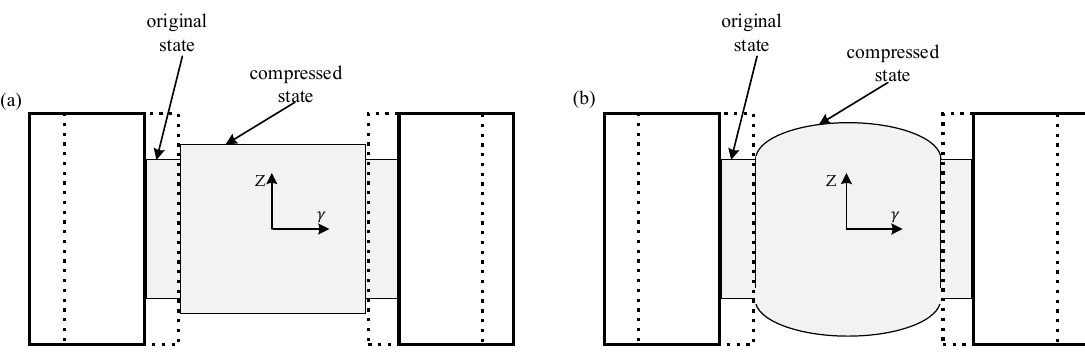
Figure 2. Geometric description of the deformed SHPB specimen under compression. ( a ) Frictionless interface and ( b ) frictional interface.